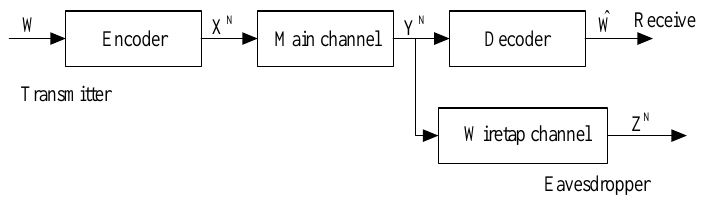
Figure 1. Communication model of degraded wiretap